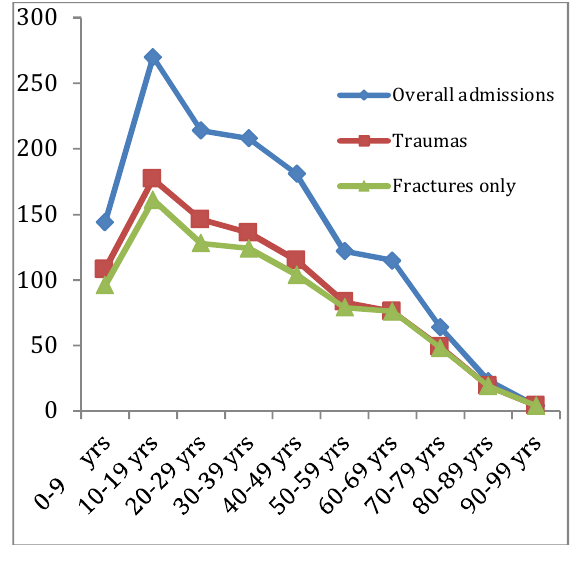
Figure 6. Age specific incidence